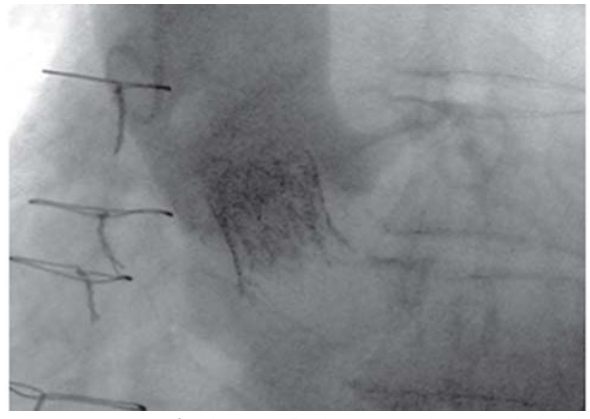
Fig. 2 - Aspecto da sutura em bolsa e preparo para colocação do introdutor de 24 Fr